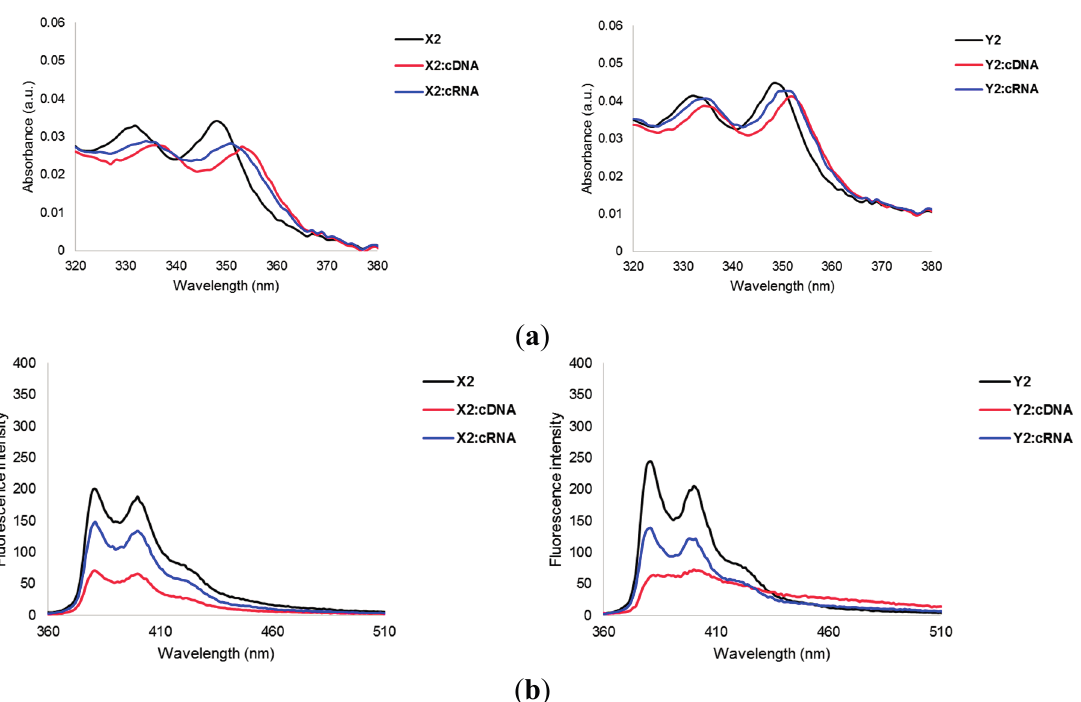
Figure 2. ( a ) Absorbance spectra of representative PS-DNA strands X2 and Y2 and the corresponding duplexes with cDNA/cRNA. Spectra were recorded at T = 5